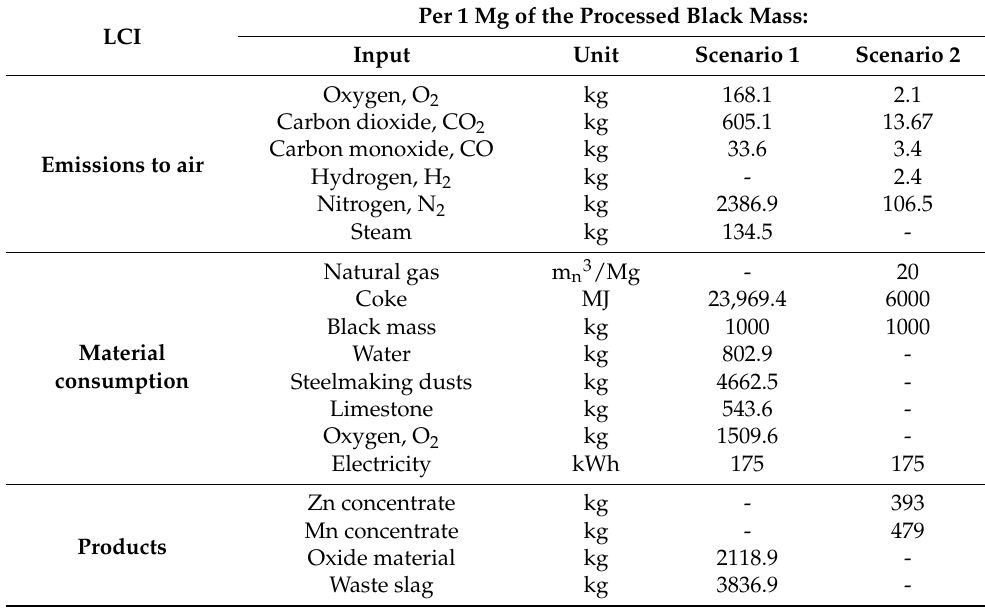
Table 1. Life-cycle inventory: Scenario 1—black mass as a co-substrate in steelmaking dust processing in Waelz kiln, and Scenario 2—waste-free technology of black mass processing in Waelz